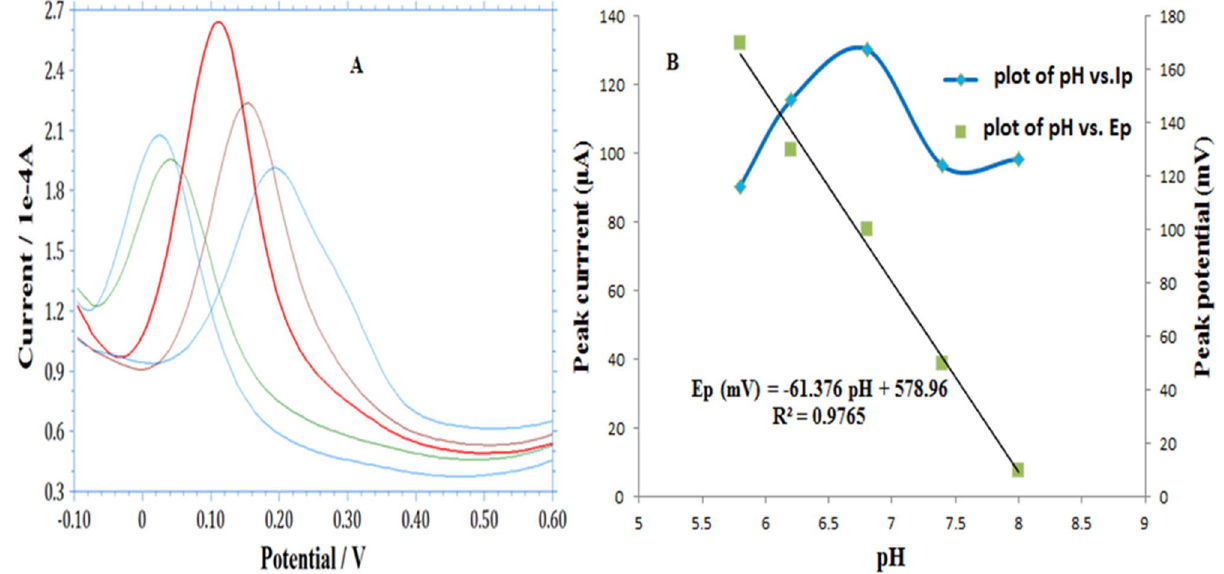
Figure 7. ( A ) Square wave voltammograms of p-NP (1.66 × 10 –6 M) at GN:ZnO NC /GCE at different pH values (5.8, 6.2, 6.8, 7.4, 8 from right to left). Deposition potential: − 1 V. Deposition time 300 s. ( B ) Plot of pH against peak current (Ip) and peak potential